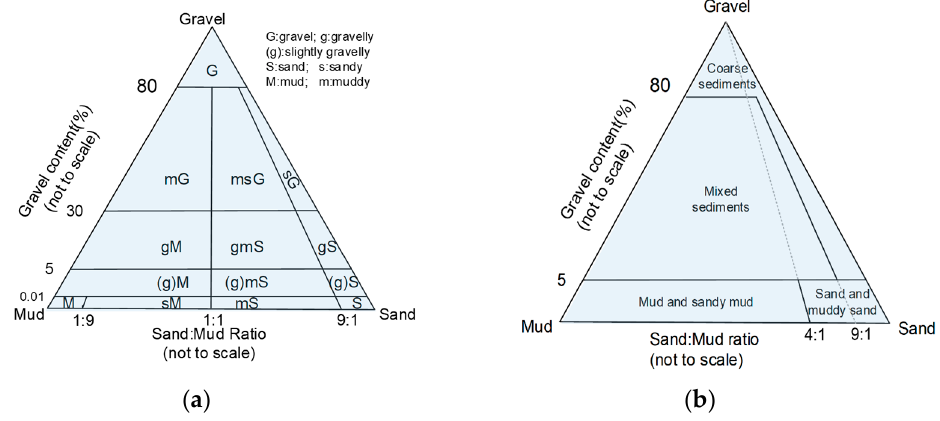
Figure 2. Ternary diagram showing ( a ) Folk and ( b ) EUNIS classification system [45].